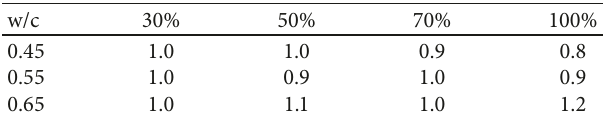
Figure 7: Carbonation behavior of RAC with (a) various RA contents and (b) various average water absorption rates [54, 69, 70, 77, 102–113]. Table 3: Reference value of k RA with various RA replacement percentages